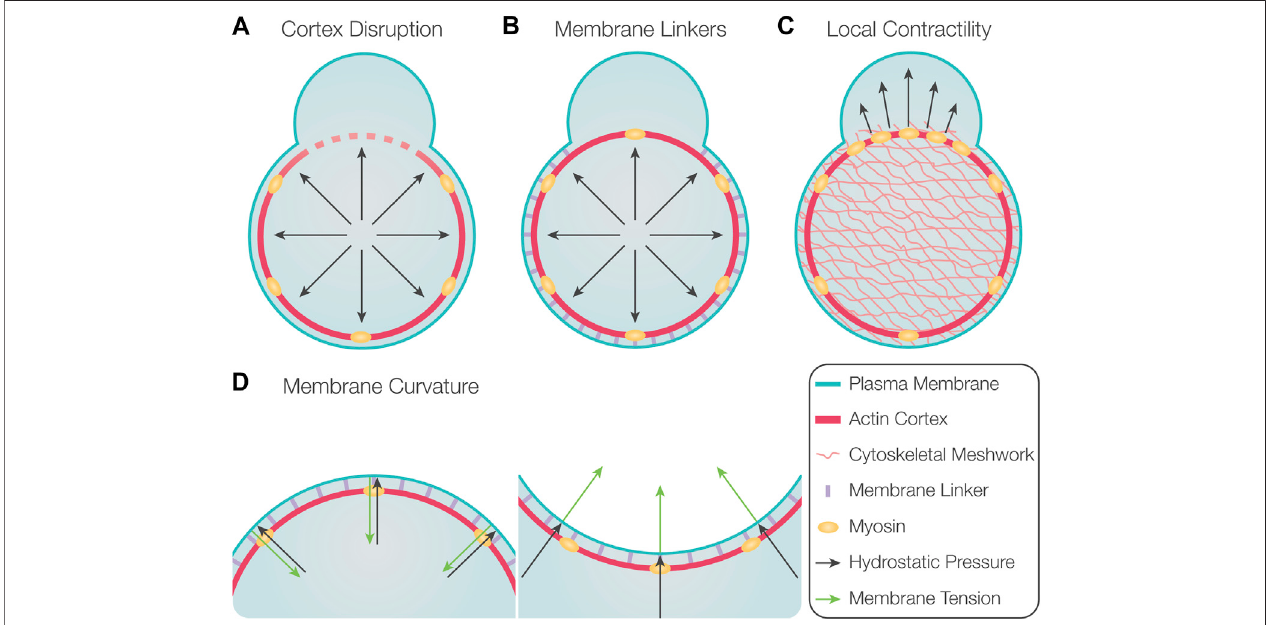
FIGURE 2 | Factors controlling the position of bleb formation. (A) Global hydrostatic pressure induces bleb formation at locations where the actin cortex is disrupted. (B) Preferentialinitiationofblebsatlocationswithreducedlevelsofmembranelinkermolecules. (C) Locallyincreasedcontractilitycouldinduceblebformation at these loci if poroelastic properties of the cytosol prevent rapid pressure equilibration. (D) Depending on membrane curvature, the force resulting from membrane tension is either directed inward in the case of positive membrane curvature (left) or outward for negative membrane curvature (right). Therefore, membrane delamination occurs more readily at locations of negative membrane